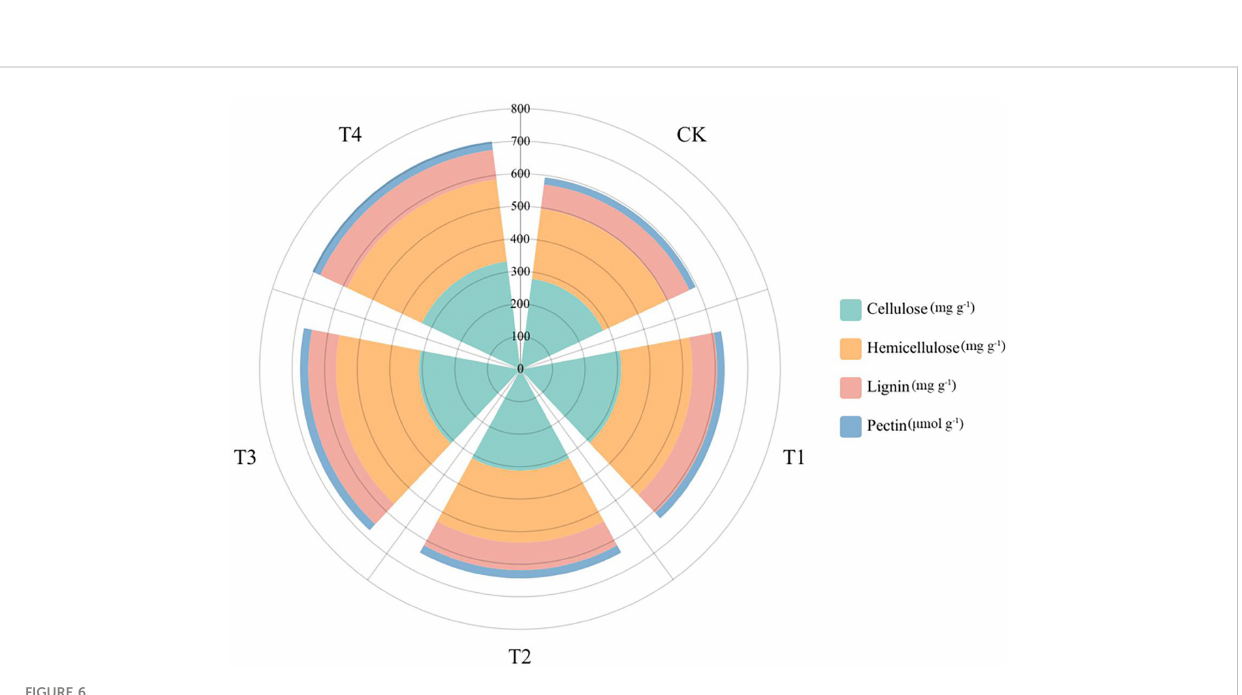
FIGURE 6 Cell wall components of S. alfredii under different Si treatments. CK: control treatment, T1, T2, T3 and T4 were the Si concentrations of 0.5, 1.0, 1.5 and 2.0 mmol ∙ L -1 , respectively.